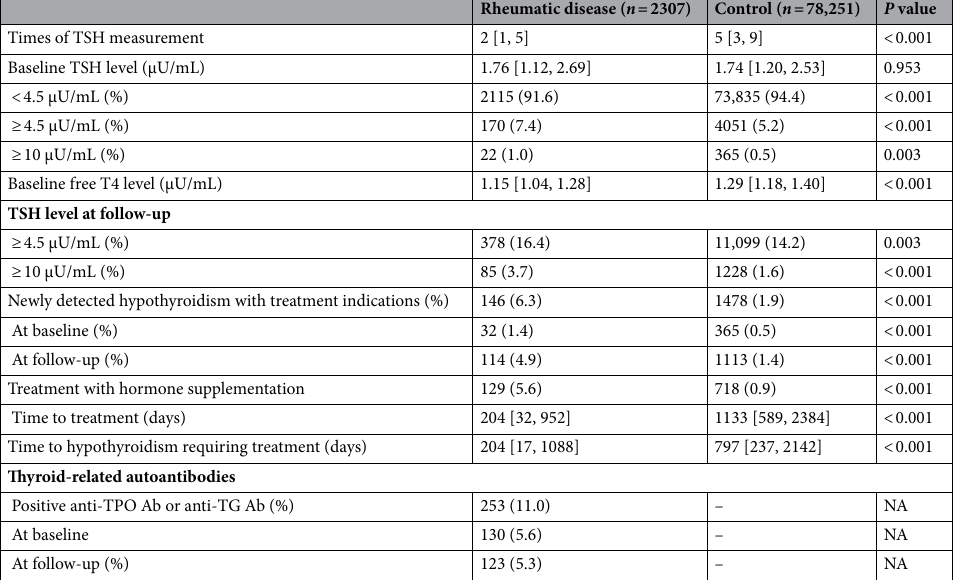
Table 2. Results of thyroid function test and prevalence of hypothyroidism. Variables are shown as mean (SD) or median [IQR]. anti-TG Ab anti-thyroglobulin antibody, anti-TPO Ab anti-thyroid peroxidase, IQR interquartile range, SD standard deviation, T4 thyroxine, TSH thyroid-stimulating hormone.